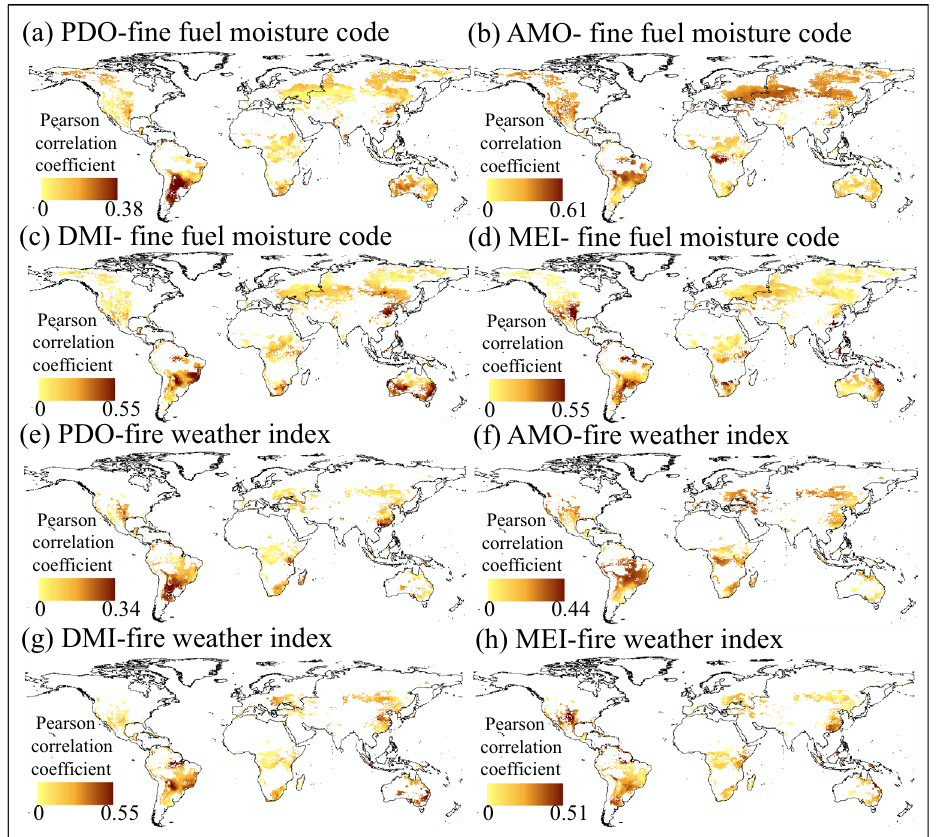
Fig. 10 Distribution map-3 of correlation coefficients of atmospheric–oceanic indices and wildfire-related variables. This dstribution map-3 shows the effects of the four atmospheric-oceanic indices on fine fuelmoisture code and fire weather index through pearson correlation coefficients. Blank indicates thatno wildfires or change-points have occurred on the grid. PDO: Pacific Decadal Oscillation Index.MEI: Multivariate El Niño-Southern Oscillation Index. AMO: Atlantic Multi-decadal OscillationIndex. DMI: Dipole Mode